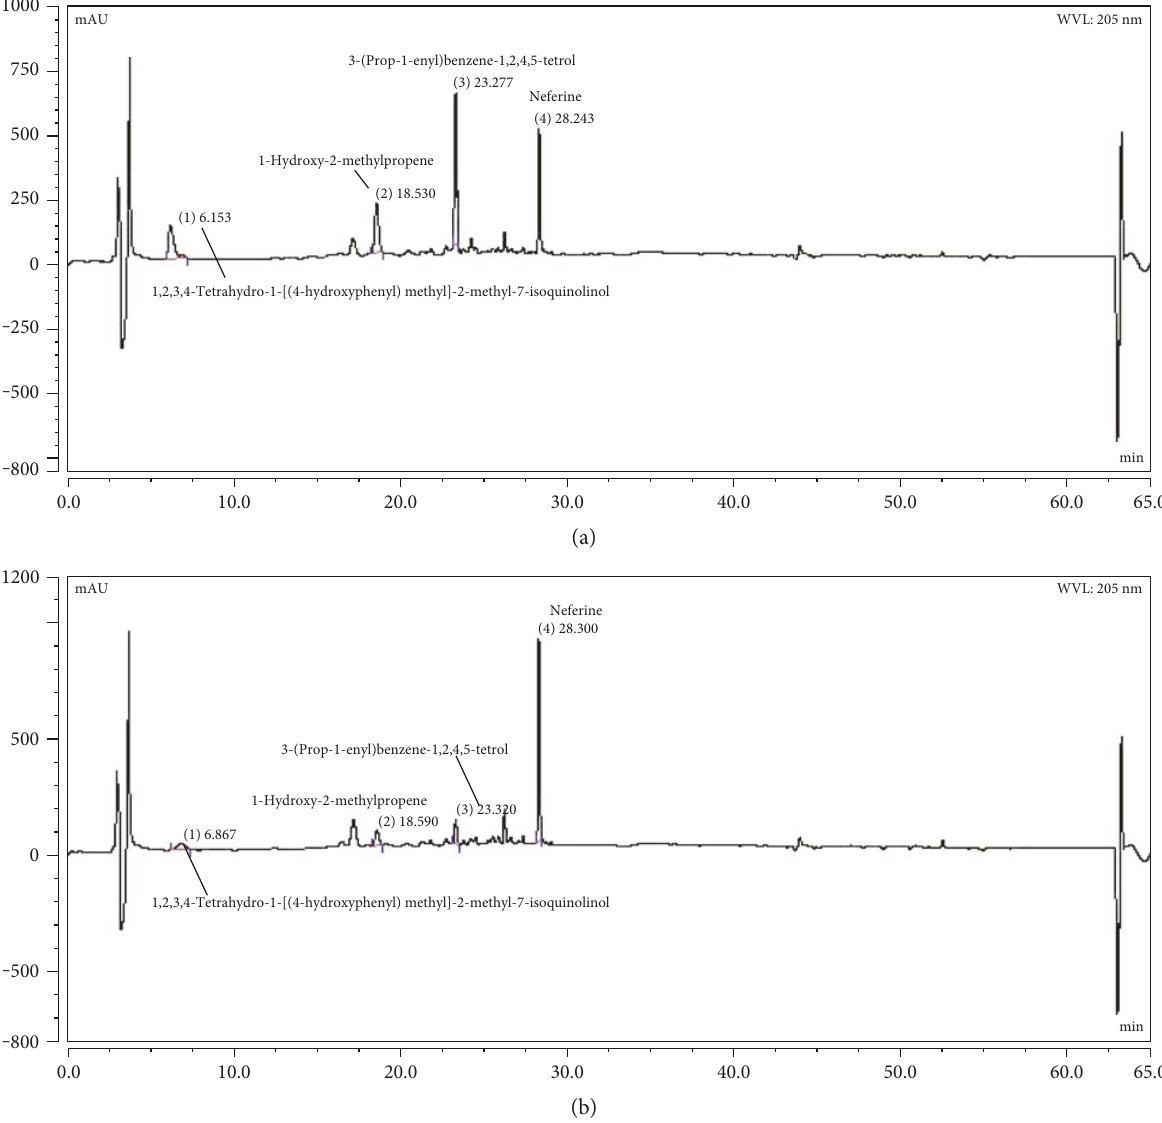
Figure 2: The HPLC-DAD chromatograms of standard compounds (a) and compounds from N. nucifera embryos extracted with 80% methanol (b). 1,2,3,4-Tetrahydro-1-[(4-hydroxyphenyl) methyl]-2-methyl-7-isoquinolinol (1), 1-hydroxy-2-methylpropene (2), 3-(prop-1- enyl)benzene-1,2,4,5-tetrol (3), and neferine